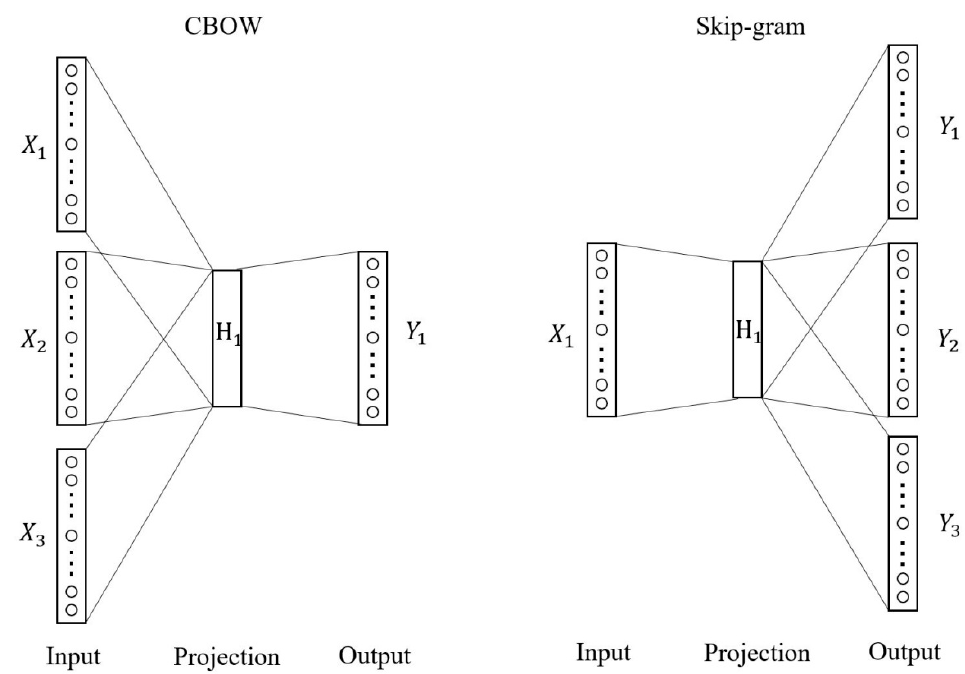
Figure 1. Word2vec model (Continuous Bag of Words (CBOW) and Skip-Ngram).